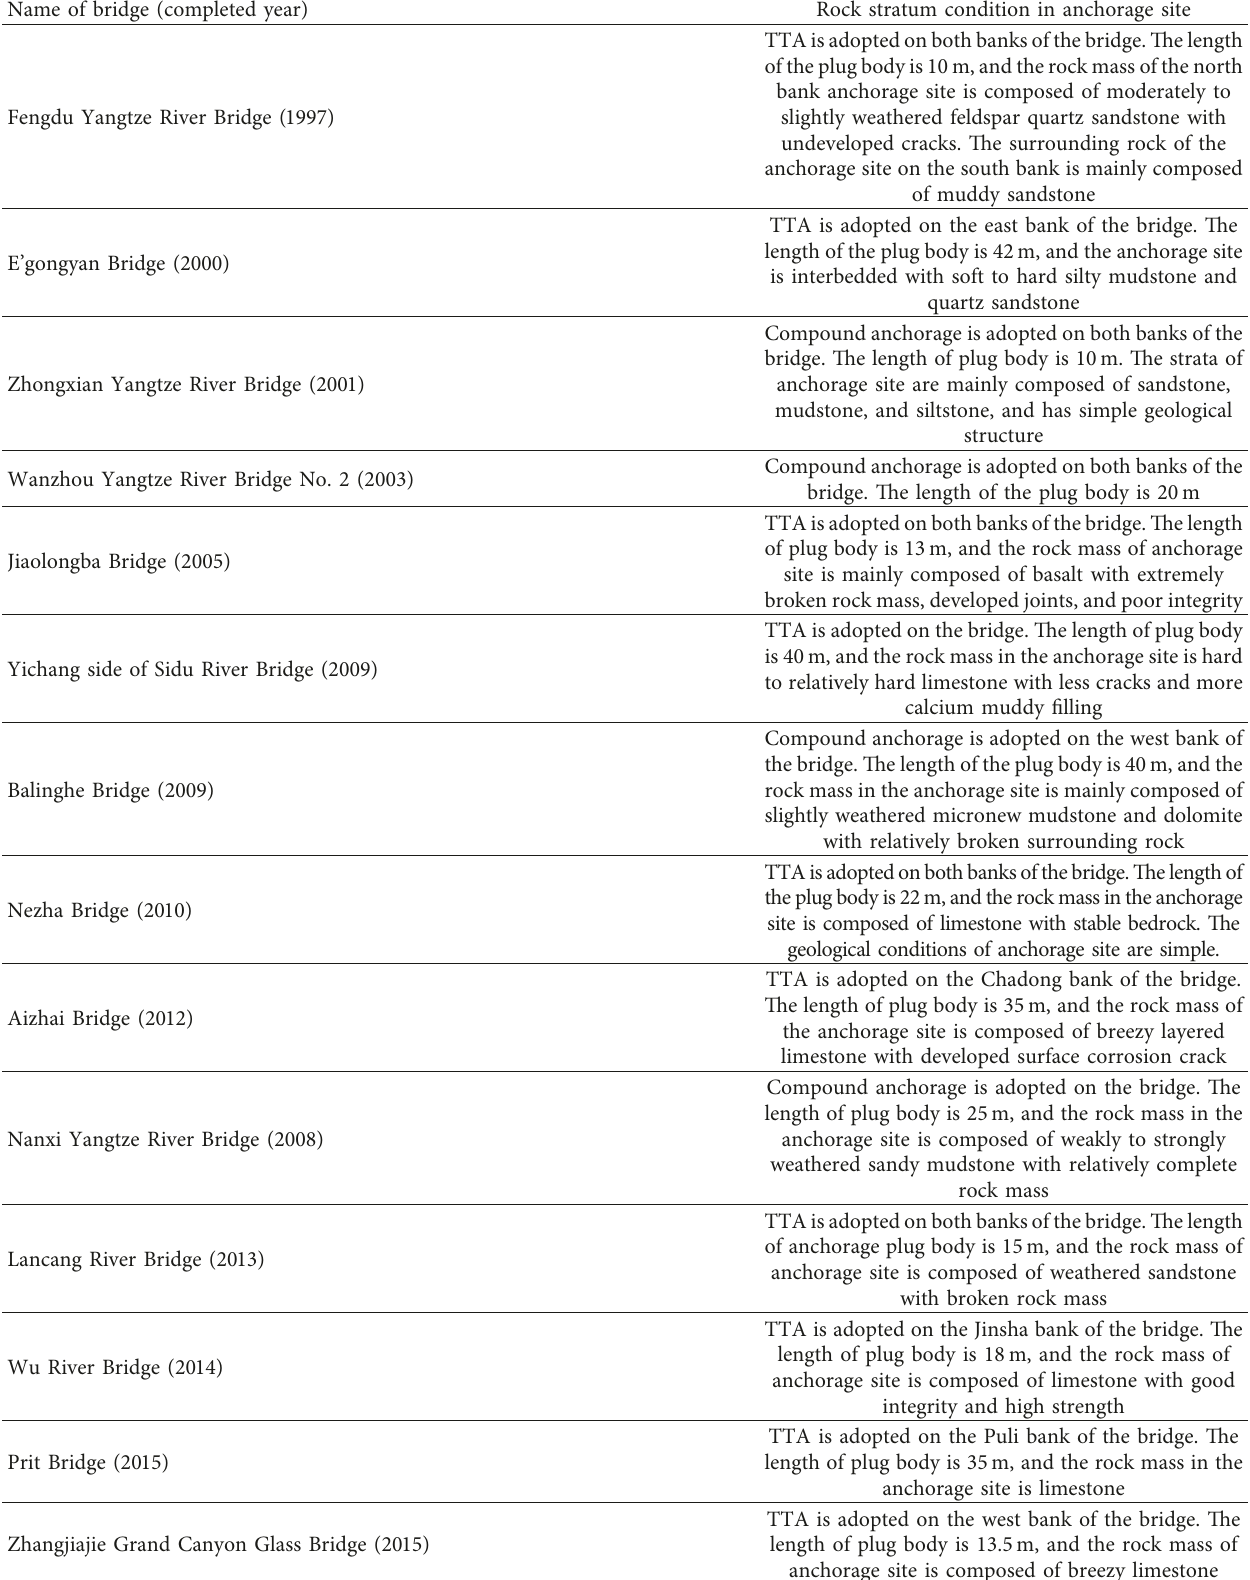
Table 1: Information on suspension bridges built by TTAs in